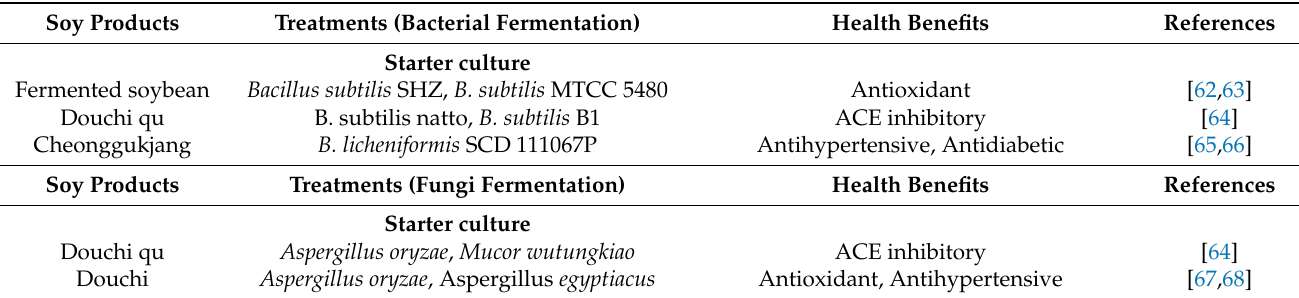
Table 1. Effect of heat, fungi, and bacterial treatments on soy and soy-based